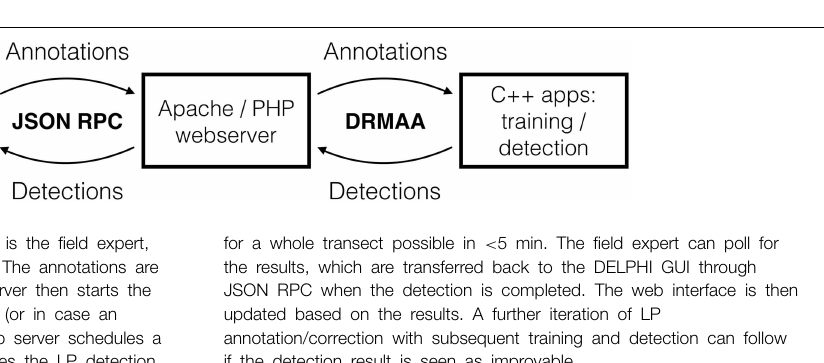
FIGURE 1 | Screenshot of the DELPHI web interface. In the black top bar are the main navigation elements: on the left is a drop-down menu to select the transect within which laser points will be detected (A) . Next to that, some information regarding the amount of laser point annotations and the detection performance are given (if available) (B) . On the right, there is a visualization of the amount of annotations made (C) , a selection box containing already trained detectors for other transects (D) , as well as the button to train the detection system or start a detection (E) . Directly below, a horizontal visualization of the complete transect is shown, spanning the